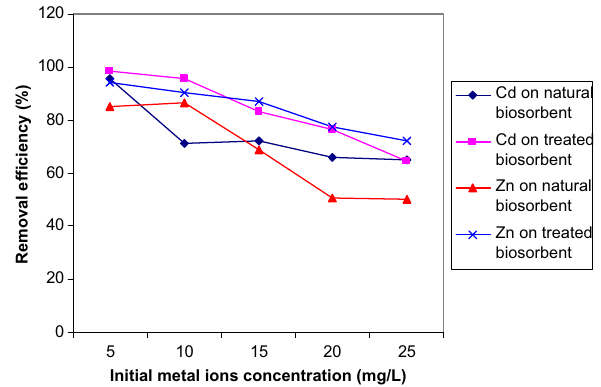
Fig. 6 Effect of initial metal ions concentration on Cd and Zn